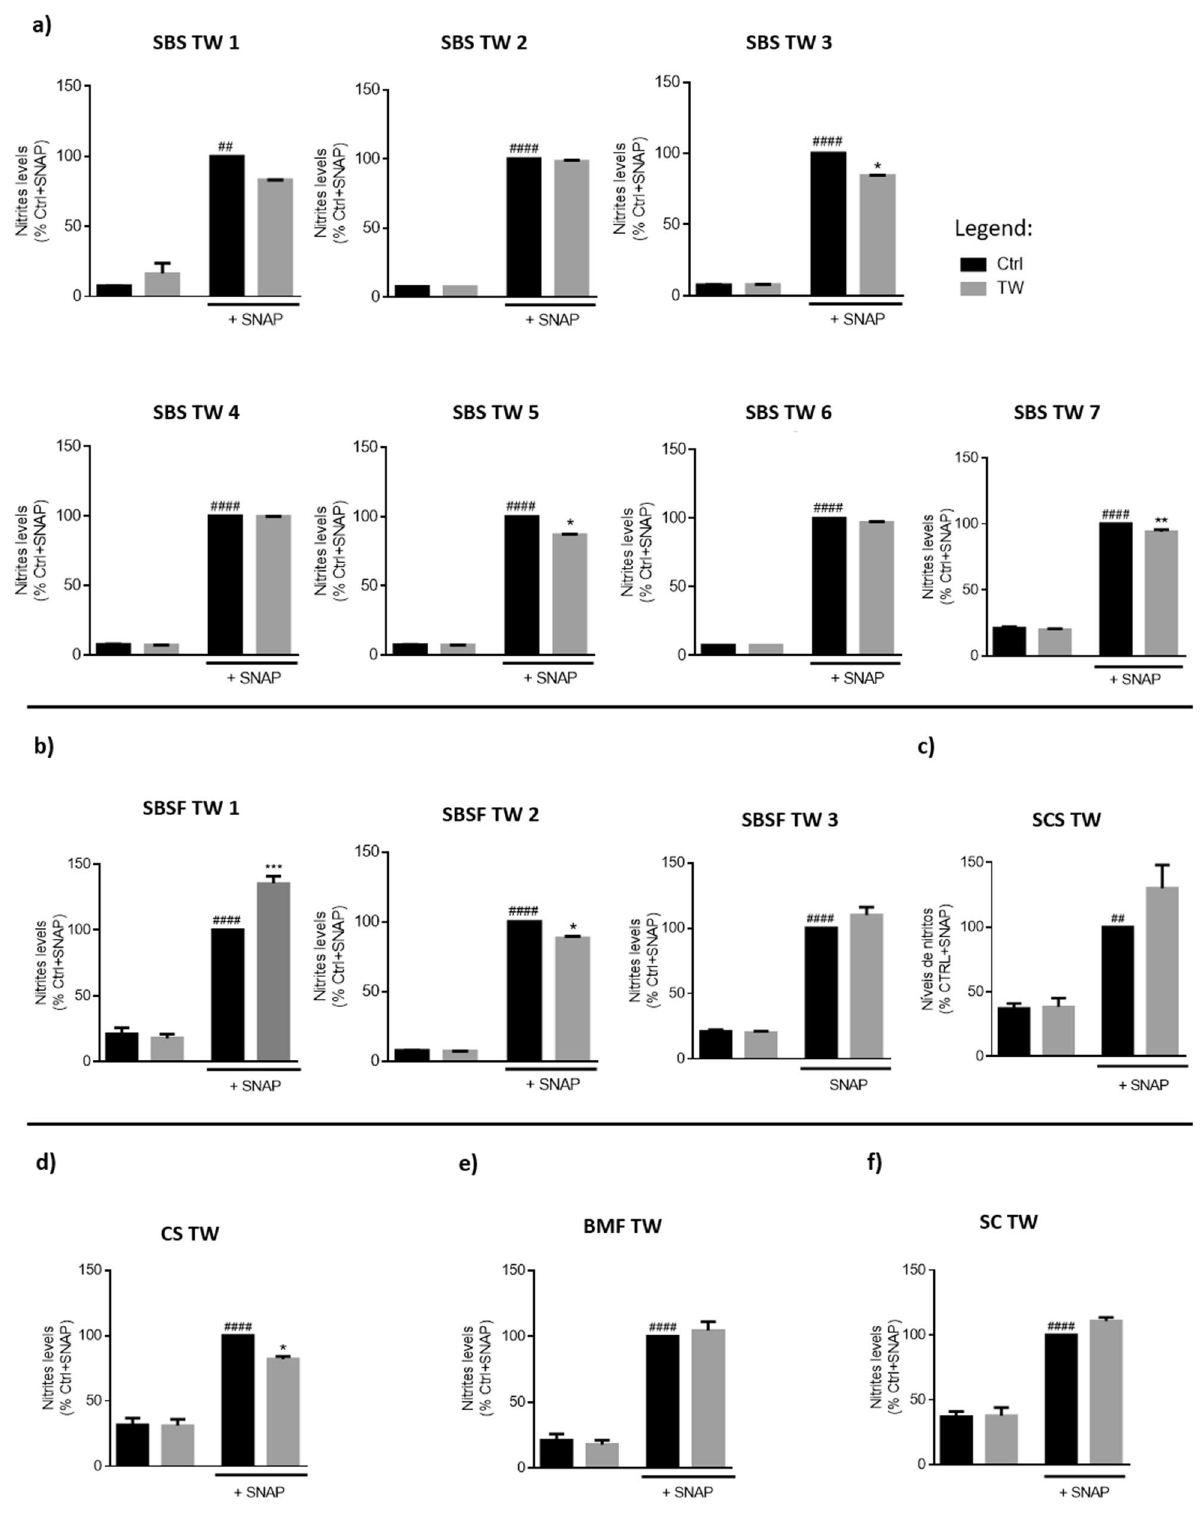
Figure 4. Thermal waters NO scavenging capacity. A NO donor, S-nitroso-N-acetylpenicillamine (SNAP, 300 µM) was added to Ctrl medium or medium prepared with SBS ( a ), SBSF ( b ), SCS ( c ), CS ( d ), BMF ( e ) and SC ( f ) thermal waters (TW), for 3 h. Griess assay was performed to assess nitrites levels in the supernatant. Data correspond to the means ± SEM of at least three independent experiments and are represented as % of Ctrl medium with SNAP (Ctrl). Statistical analysis: two-way ANOVA with Tukey’s multiple comparison test; p < 0.05 was considered significant: * p < 0.05, ** p < 0.01, *** p < 0.001, compared to Ctrl + SNAP; ## p < 0.01, #### p < 0.0001, compared to Ctrl. Legend: SBS sulphurous/bicarbonate/sodic, SBSF sulphurous/bicarbonate/sodic/fluoridated, CS chlorinated/sodic, SCS sulphurous/chlorinated/sodic, BMF bicarbonate/magnesium/ferric, SC